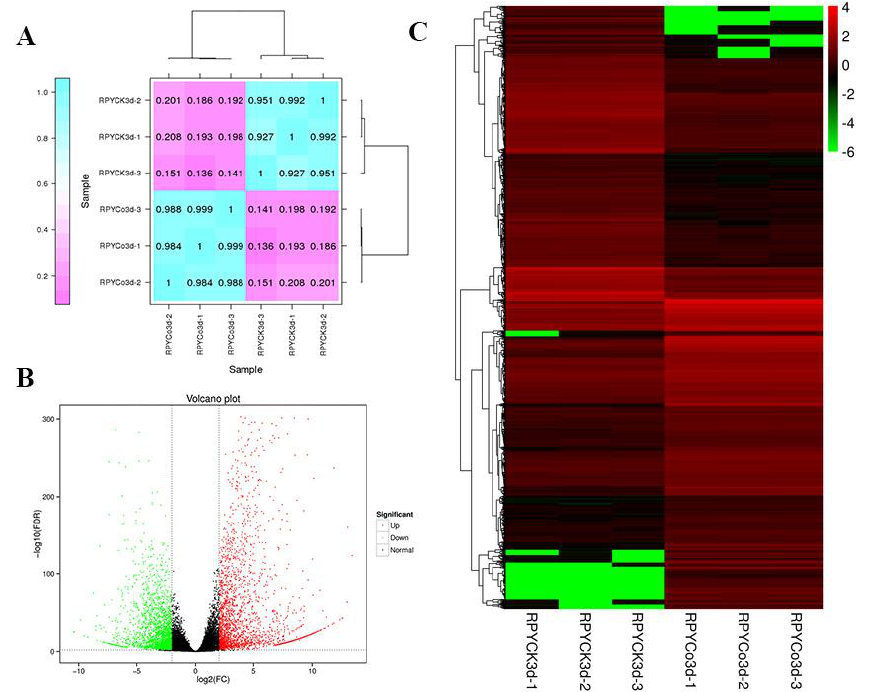
Table 1. Summary information of sequencing data and mapped ratios.